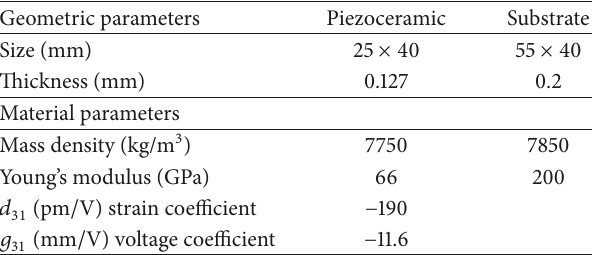
In the bandwidth, the normalized voltage of the conven- tional system at 3 dB below the peak is 65.6 V/g. The three cases of the proposed system (i.e., Hole 1, Hole 2, and Hole 3) show significant increases in bandwidth of 234.3, 228.6, and 208.6%, respectively, compared to the conventional system. Insets in Figure 5 are the relative total strains at resonance frequency of each case from FEM simulations. The analysis mass in the static state. Conventional system shows that